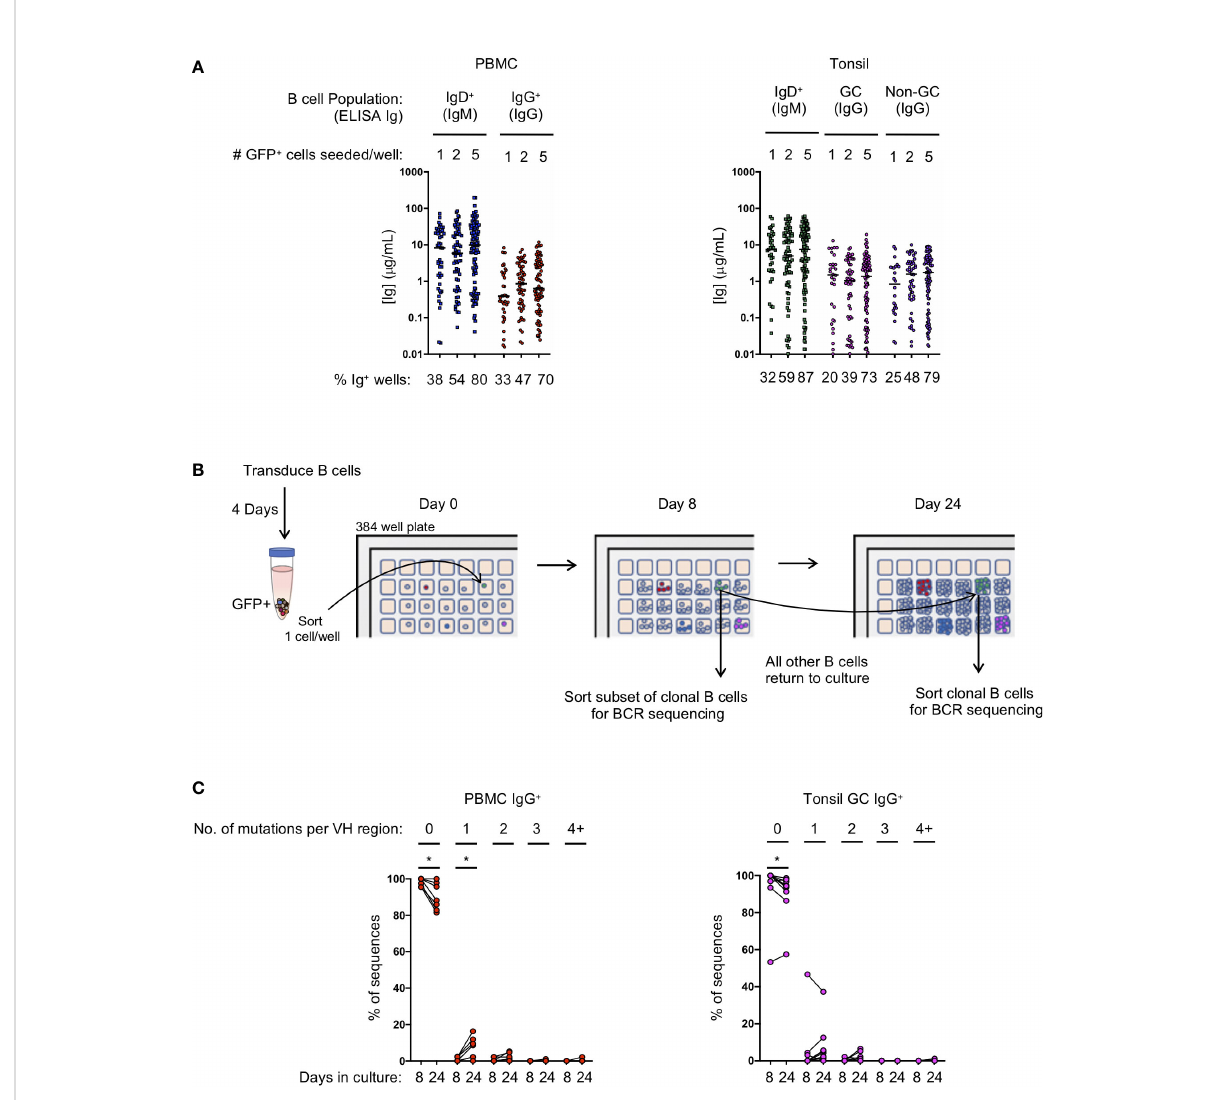
FIGURE 2 Transduced B cell populations expand and secrete immunoglobulin during 24 days of microculture. (A) Ig supernatant concentrations of IgM and IgG from PBMC (left) and tonsil (right). Horizontal bars indicate the median Ig concentration. The mean frequency of Ig positive wells is indicated at the bottom of the plots (n=3 for PBMC; n=3 for tonsil). (B) Outline of the procedure to determine the number of mutations acquired during in vitro culture. (C) Frequency of sequences within each clone that acquired either zero, 1, 2, 3 or 4 or more mutations within the VH domain after 8 or 24 days in culture (B: IgG PBMC clones, n=7; C: GC IgG tonsil clones, n=9). Signi fi cant differences between days 8 and 24 were determined by Wilcoxon matched-pairs signed rank test.